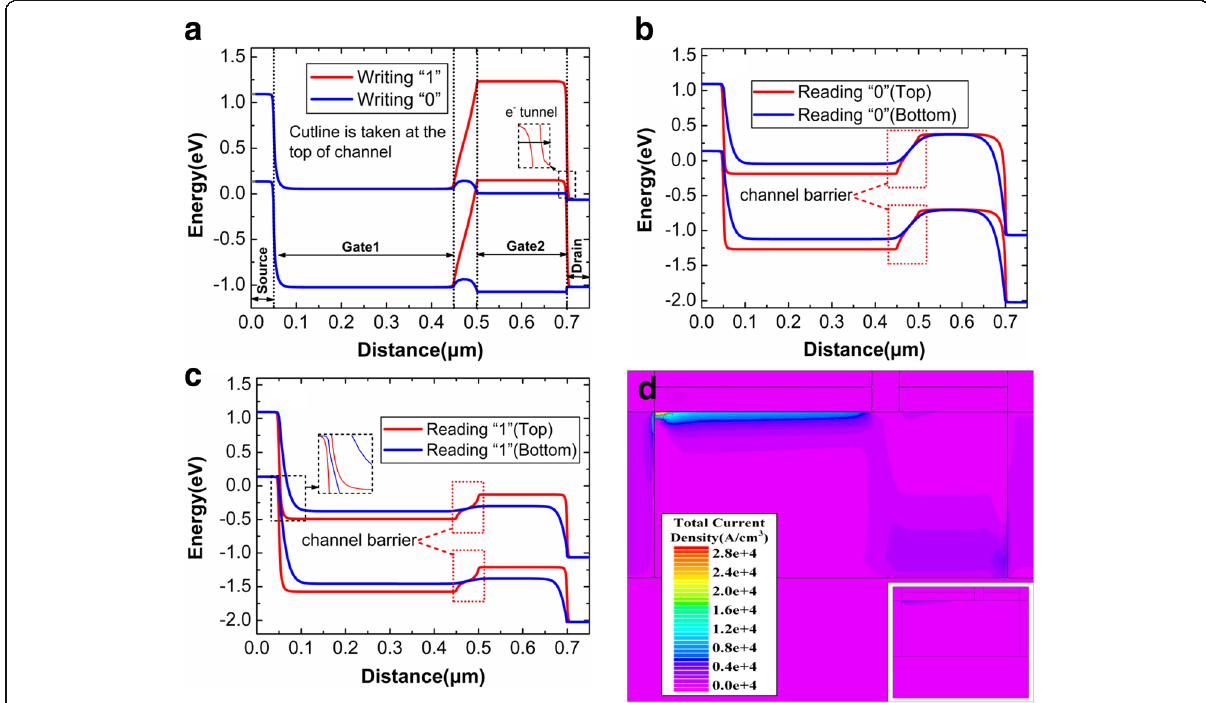
Fig. 2 Energy bands from source to drain. a Energy bands after writing “ 1 ” with negative Gate2 bias and after writing “ 0 ” with positive Gate2 bias. b Energy bands at the top and bottom of channel after reading “ 1 ” . c Energy bands at the top and bottom of channel after reading “ 0 ” . d Total current density after reading “ 1